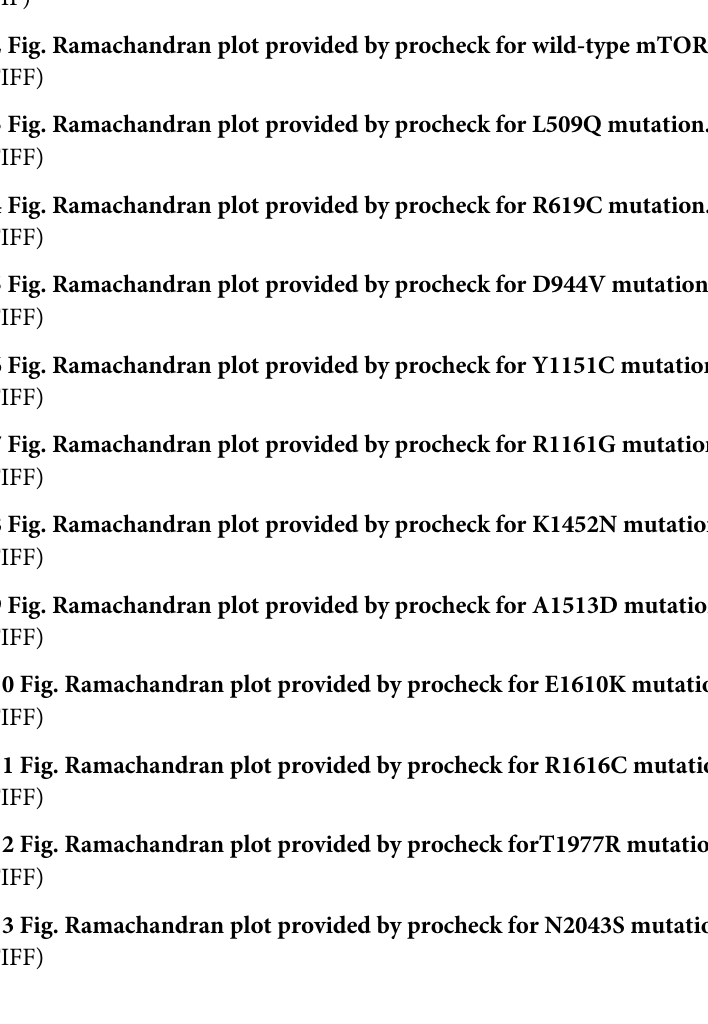
S1 Fig. Protein interaction network of mTOR protein. (TIF) S2 Fig. Ramachandran plot provided by procheck for wild-type mTOR protein. (TIFF) S3 Fig. Ramachandran plot provided by procheck for L509Q mutation. (TIFF) S4 Fig. Ramachandran plot provided by procheck for R619C mutation. (TIFF) S5 Fig. Ramachandran plot provided by procheck for D944V mutation. (TIFF) S6 Fig. Ramachandran plot provided by procheck for Y1151C mutation. (TIFF) S7 Fig. Ramachandran plot provided by procheck for R1161G mutation. (TIFF) S8 Fig. Ramachandran plot provided by procheck for K1452N mutation. (TIFF) S9 Fig. Ramachandran plot provided by procheck for A1513D mutation. (TIFF) S10 Fig. Ramachandran plot provided by procheck for E1610K mutation. (TIFF) S11 Fig. Ramachandran plot provided by procheck for R1616C mutation. (TIFF) S12 Fig. Ramachandran plot provided by procheck forT1977R mutation. (TIFF) S13 Fig. Ramachandran plot provided by procheck for N2043S mutation.